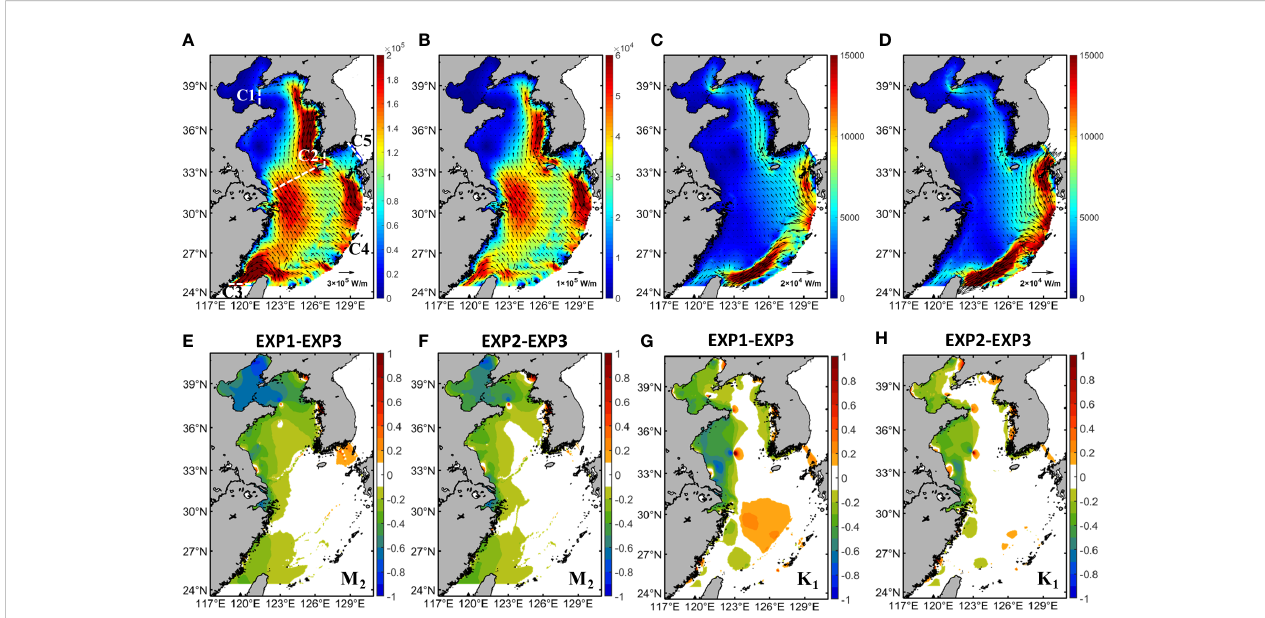
FIGURE 8 (A – D) Vectors of depth-averaged tidal energy fl ux for M 2 , S 2 , K 1 , and O 1 tides in EXP 3, respectively. Colormaps denote the magnitude of tidal energy fl ux. (E – H) Relative differences of semidiurnal and diurnal tidal energy fl ux between EXP 1, EXP 2 to EXP 3,